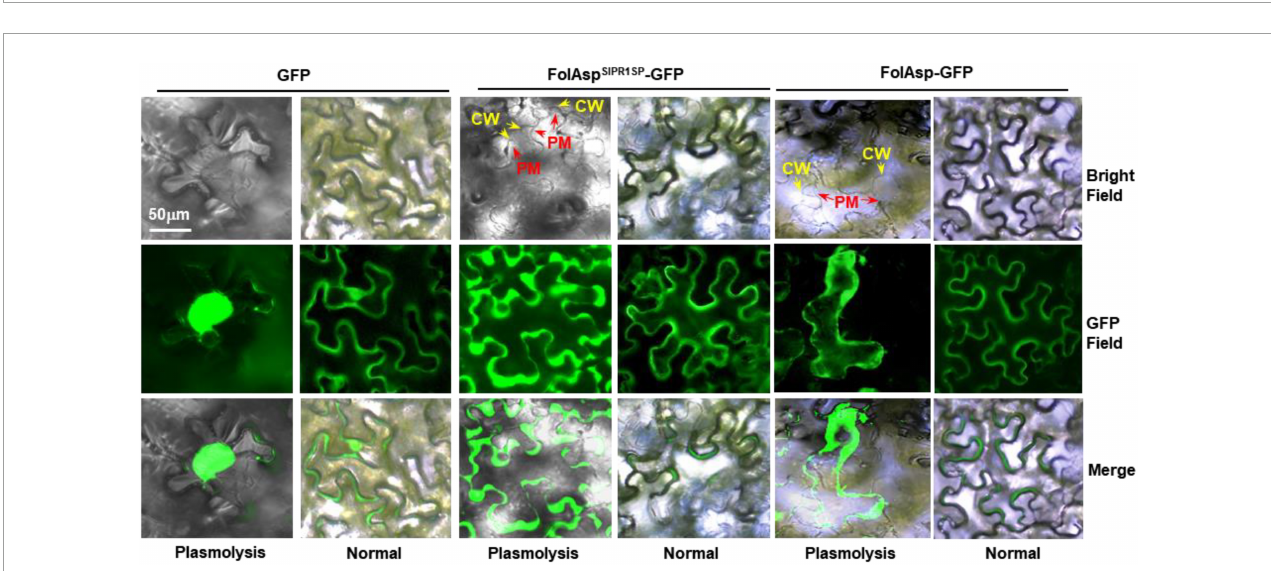
FIGURE4 Subcellular localization of FolAsp in tobacco leaves. FolAsp-GFP indicates the fusion protein with its native N-terminal signal peptide. FolAsp SlPR1SP -GFP indicates replacement of its native signal peptide with the tomato PR1 signal peptide (N-terminal 1–24 amino acids). Images were taken at 3 DAI. The plasmolysis was visualized after treatment with 800 mM mannitol for 6 h. CM, cell wall; PM, plasma membrane.